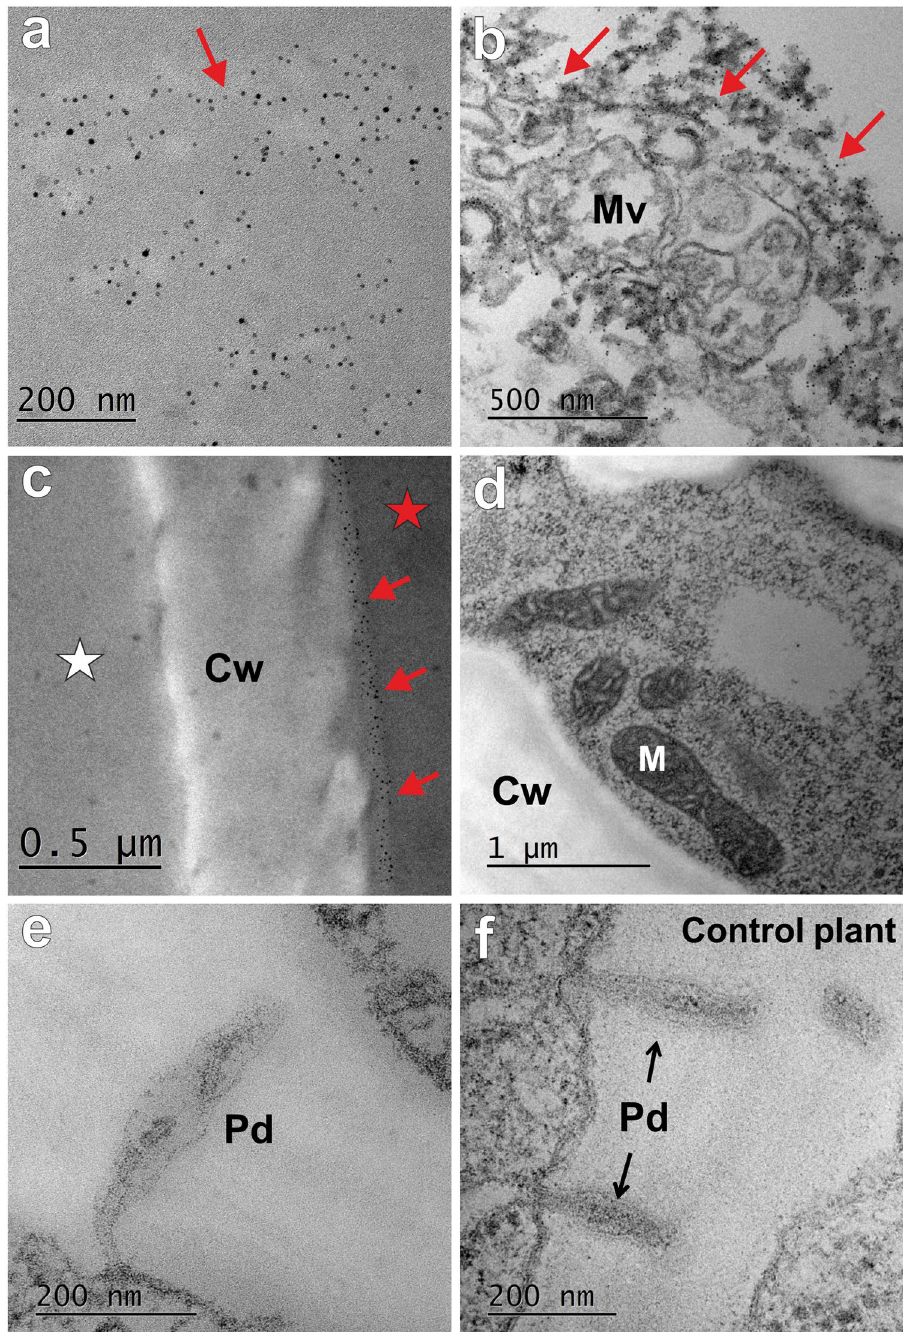
Figure 4. Representative ultrastructure of the punctured barley root cells that had been treated with 5 nm AuNPs ( a–e ) and a control plant ( f ). ( a , b ) Punctured cells with nanoparticles localised only in the cytoplasm (red arrows) but not in the organelles or plasmodesmata ( d , e ). ( c ) The AuNPs that were detected in the cytoplasm were observed mostly adjacent to the cell wall (red arrows) of a punctured cell (red asterisk); AuNPs were not found in neighbouring, unwounded cell (white asterisk). Cw – cell wall; M – mitochondrion; Mv – multivesicular body; Pd –